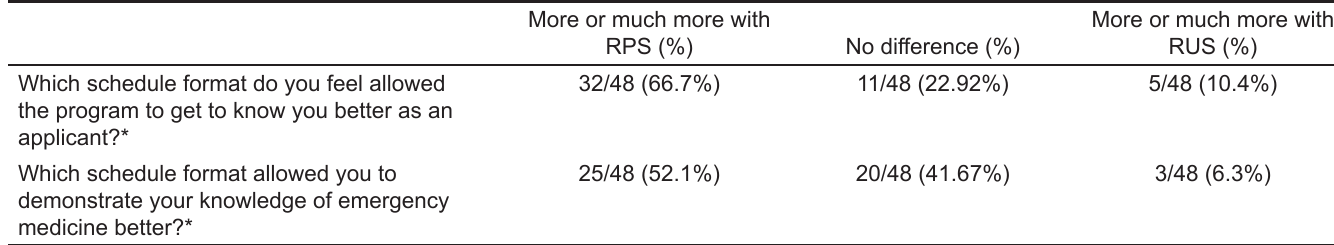
Table 2 . Audition